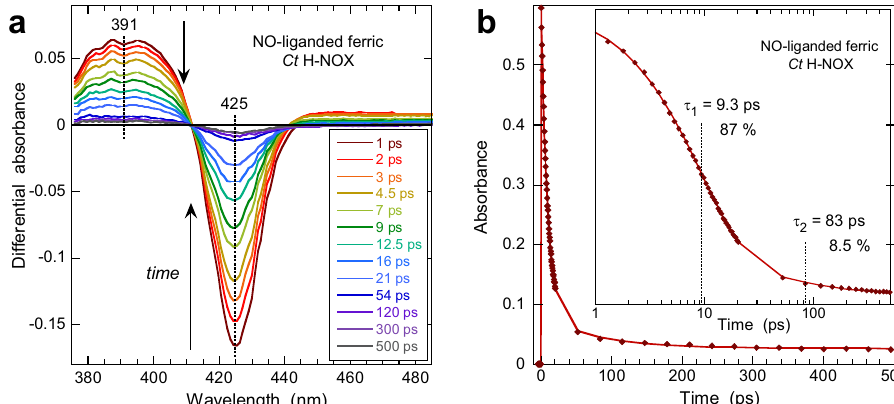
Fig. 3 Dynamics in ferric Ct H-NOX sensor. a Transient difference absorption spectra after the photodissociation of NO from ferric heme at increasing time delay ( λ ex = 564 nm). b Kinetics of NO geminate rebinding and fi t to a sum of exponential terms (logarithmic scale in the inset) with their time constants. The constant term accounts for 4.5% of the